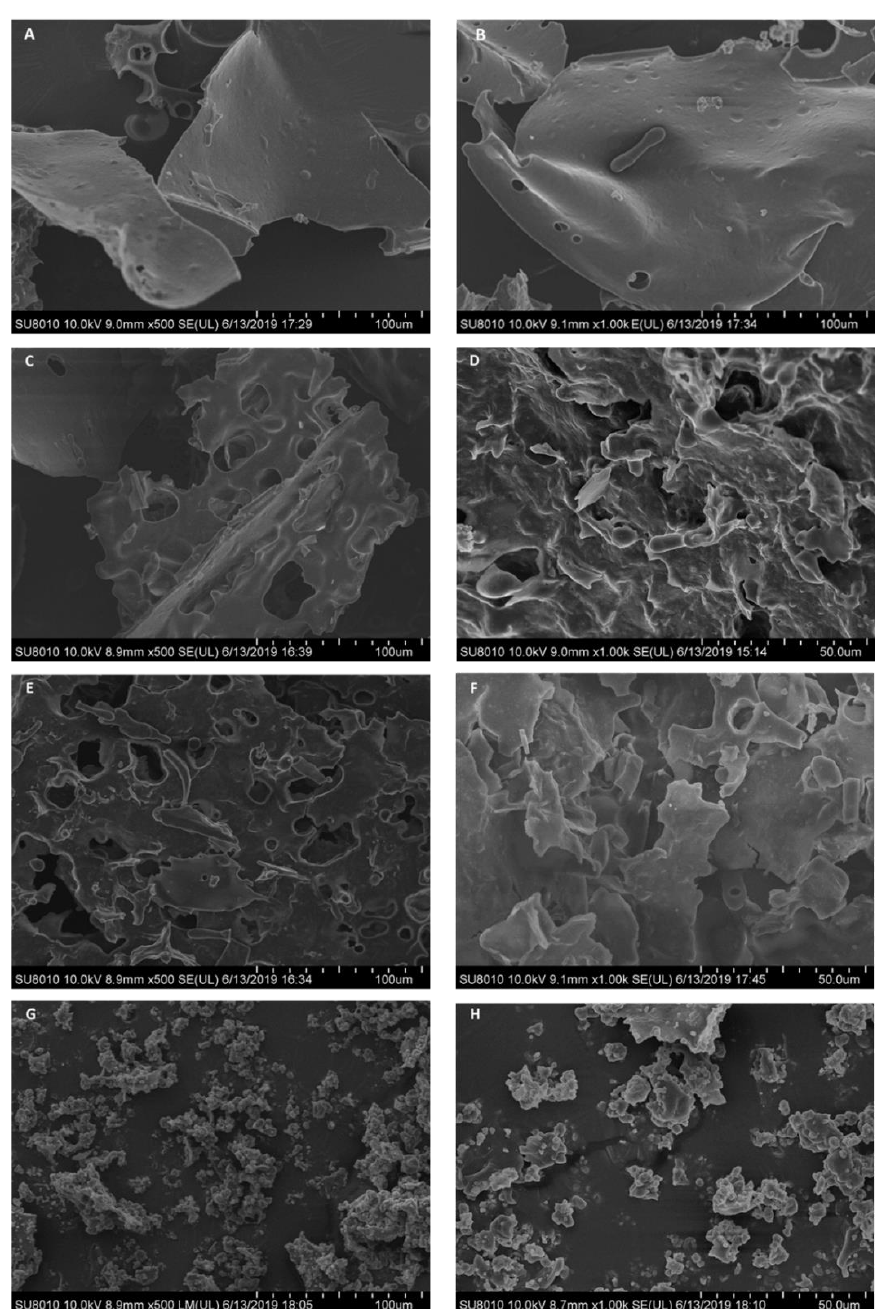
Figure 2. SEM micrographs of peanut proteins obtained through different modification methods: ( A ): peanut protein (PP) ×500; ( B ): peanut protein (PP) ×1 k; ( C ): high pressure homogenized protein (HPH) ×500; ( D ): high pressure homogenized protein (HPH) ×1 k; ( E ): high pressure homogenized and enzyme treated protein (HPH-E) ×500; ( F ): high pressure homogenized and enzyme treated protein (HPH-E) ×1 k; ( G ): HPH-E-hydrothermally cooked (HPH-E-HTC) protein ×500; ( H ): HPH-E-hydrothermally cooked (HPH-E-HTC) protein ×1 k.